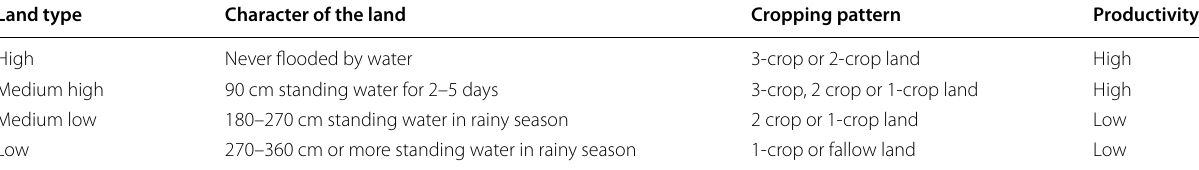
Table 6 Land types with agricultural activity in study area. Source: DAE (2014) Land